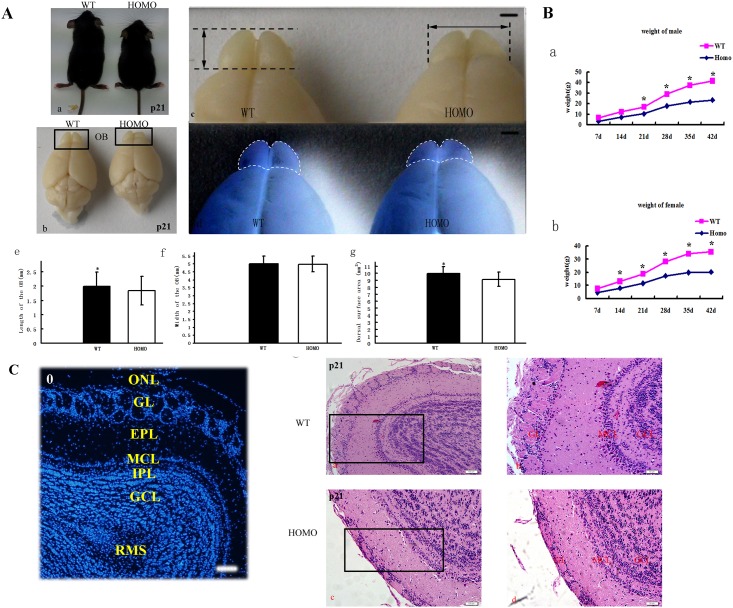
The defects of OB in Lgl1 mutants.(A) The difference in body (a) and OB (b) size between wildtype and mutant two-week-old male littermates. Lgl1 conditional mutants developed a relatively normal looking brain with noticeably smaller olfactory bulbs. Length and width were measured using a vernier caliper as indicated by arrows in c, and the dorsal surface area was quantified as indicated by dotted lines in d. (e, g) The mean length and surface area of OB were significantly different between WT and Lgl1 mutants, but no obviously changes of width (means±se, *P<0.05, paired t test, n = 9 mice/group). Scale bars: 1 mm (c, d). (B) A decrease in body weight between the wild and mutant animals was observed both in female and male mice. The significant difference of weight showed at p21 in males, while at p14 in females between wild and mutant animals (means±se, *P<0.05, paired t test, n = 9 mice/group). (C). (0) The laminar structure of OB. (a-d) A notable decrease in density and disorganization of granule cells at p21. The boundaries of the GL and GCL were fuzzy or lost in the OB of Lgl1 conditional mutants. Sections stained by H&E. (b) Boxed regions in (a), (d) and (c). ONL, olfactory nerve layer; GL, glomerular layer; EPL, external plexiform layer; MCL, mitral cell layer; IPL, internal plexiform layer; GCL, granule cell layer, RMS, rostral migratory stream. Scale bars represent 1mm in Ac and 200 μm(0), 100 μm (a,c) and 50 μm (b,d) in C.